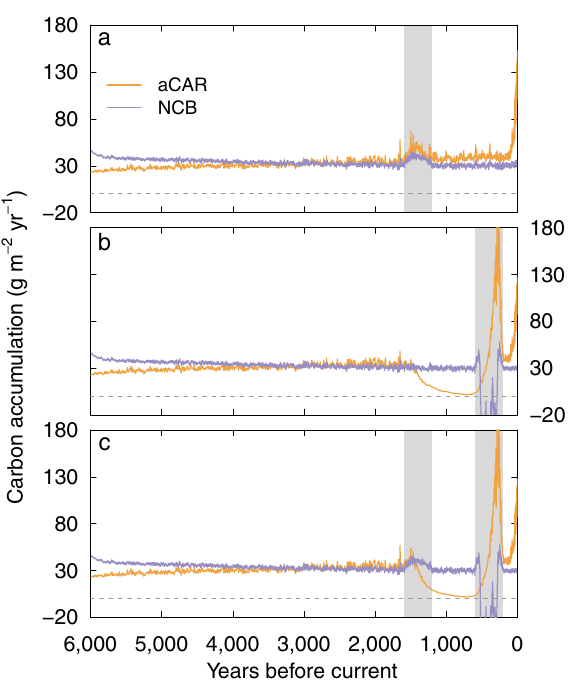
Figure 6. The effect of climate perturbations on simulated aCAR and NCB (20 year moving average). ( a ) Increase in temperature of 1.5 °C, ( b ) reduction in annual net rainfall of 0.4 m, and ( c ) both perturbations combined. The light grey vertical bars indicate the timing and duration of the perturbations and the dark grey dashed line is where C accumulation equals zero. The increases in NCB near to the beginning and end of the net rainfall perturbation ( a and b ) are due to the peatland water tables falling and later rising into the zone of maximum litter addition in DigiBog’s litter production